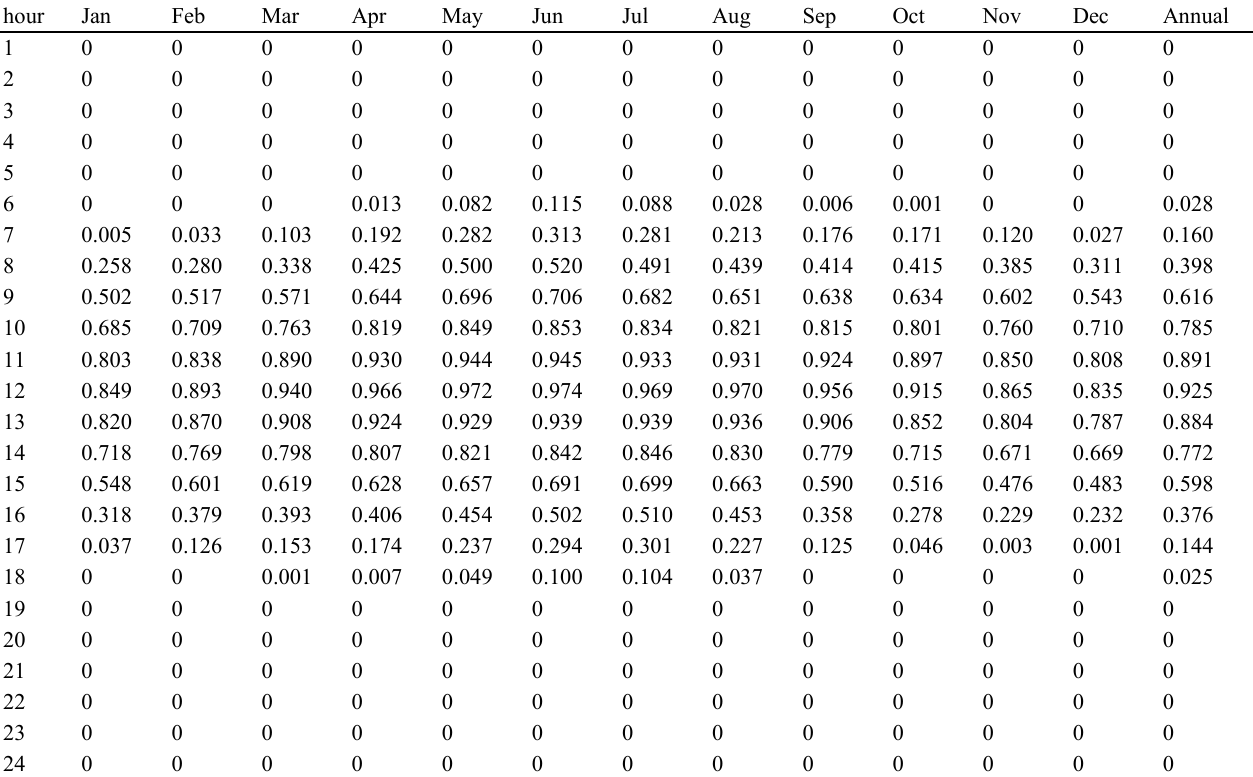
Figure 11. Daily hourly solar radiation for each month with optimum tilt angle using MATLAB program in Najaf city. Table 5. Optimized solar radiation data for Najaf city in kW/m 2